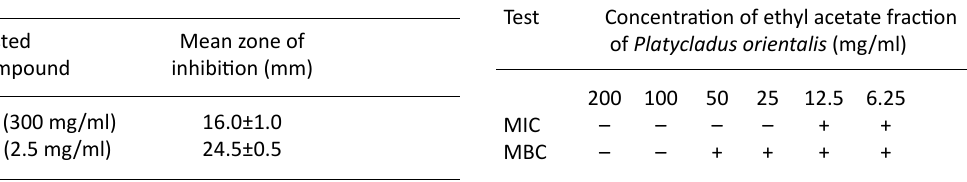
Fig. 1. Susceptibility of Staphylococcus saprophyticus to the extract of Platycladus orientalis compared with chloramphenicol Table 3. Antibacterial activity of ethyl acetate fraction of fruit of Platycladus orientalis against Staphylococcus saprophyticus